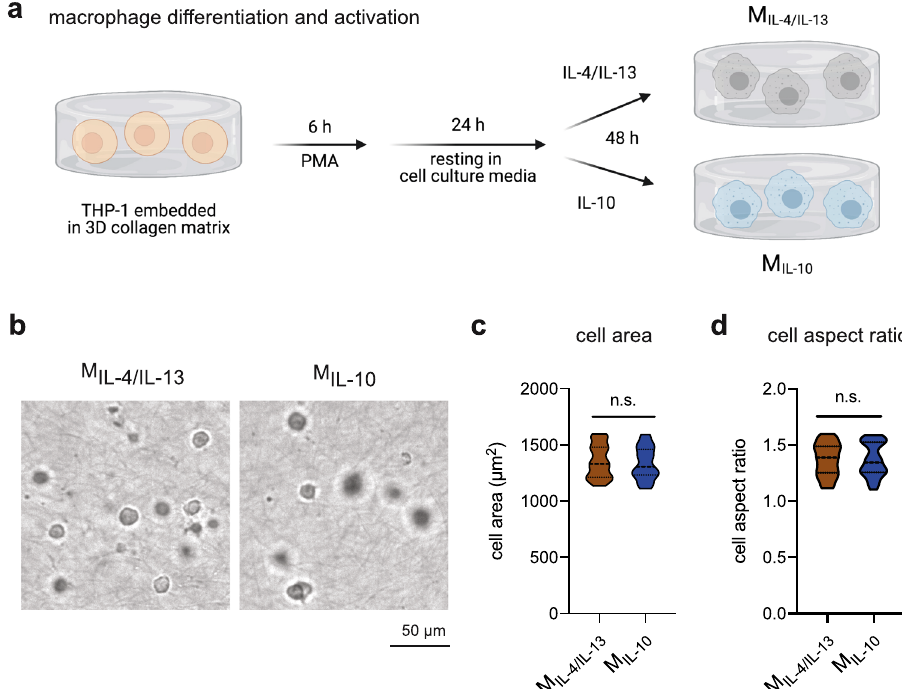
Fig. 1 Macrophage differentiation and activation in 3D collagen matrices. a Schematic work fl ow for macrophage differentiation and activation towards M IL-4/IL-13 and M IL-10 in 3D collagen matrix. b Representative images of M IL-4/IL-13 and M IL-10 were gathered using bright- fi eld microscopy. A quantitative morphological analysis, namely c cell area and d cell aspect ratio, was conducted using an image analysis toolbox. Data are presented as a violin plot. At least 100 cells from three independent experiments were